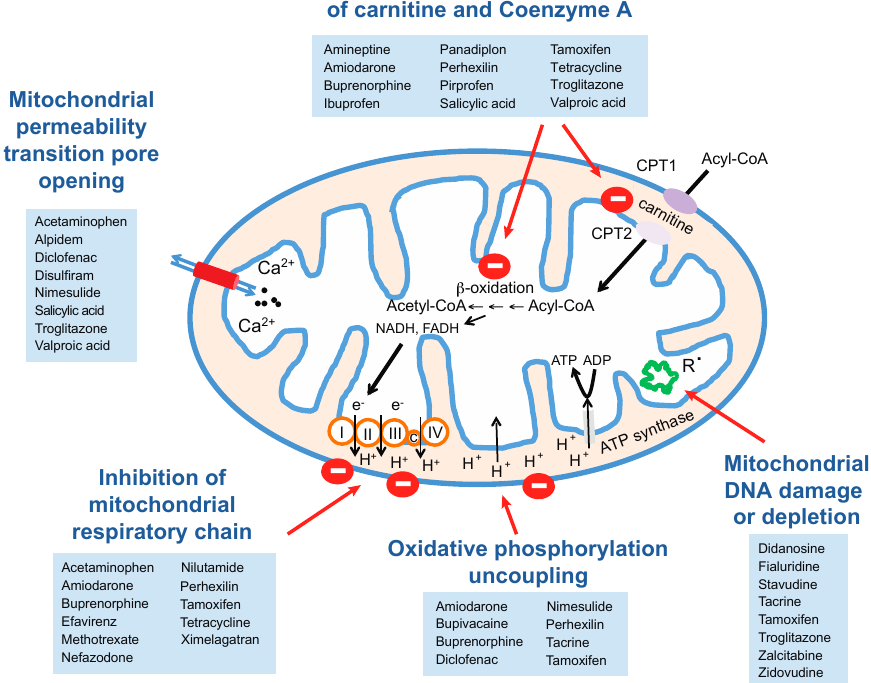
Figure 2. Schematic depiction of hepatotoxic drugs and their respective mitochondrial targets. Medications can exert toxic effects on mitochondria by targeting a variety of different processes, such as inhibition of mitochondrial respiratory chain components, uncoupling of oxidative phosphorylation or inhibition of β -oxidation and/or depletion of carnitine or coenzyme A. Some compounds, mostly antiretrovirals, can furthermore cause mitochondrial DNA depletion. Mitochondrial damage can result in opening of the mitochondrial permeability transition pore, causing loss of membrane potential, mitochondrial swelling and cell death by apoptosis or necrosis. The associated references are shown in Table 3.